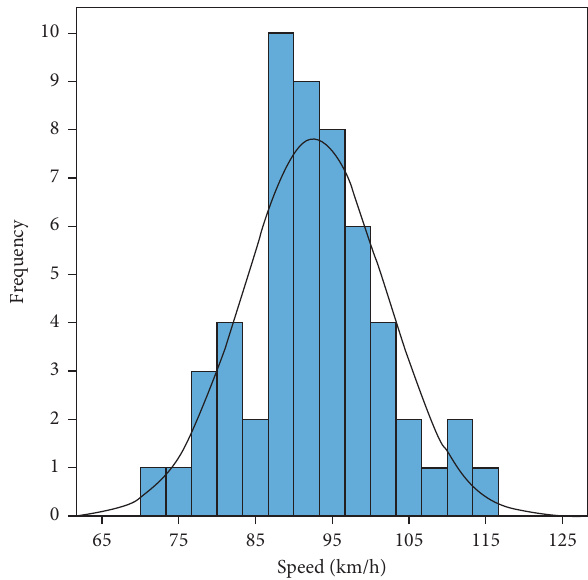
Figure 5: Histogram of free-flow speed data. Table 6: Type of manoeuvres performed according to the different LOS analysed. Type of passing manoeuvre Total LOS